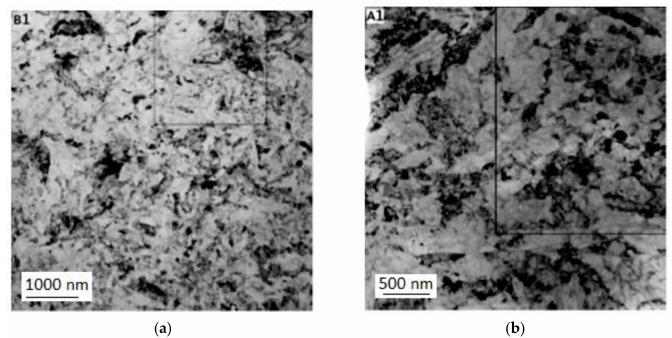
Figure 5. ( a ) Substructure in the longitudinal direction after one pass through the Conform SPD machine and rotary swaging; ( b ) substructure in the longitudinal direction after one pass and rotary